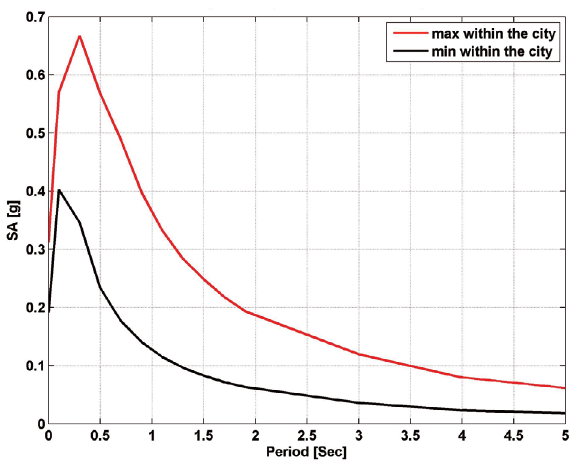
Figure 11. Estimated seismic hazard variations within the city con- sidering site effects based onVs30 variation, for a 10% probability of exceedance in 50